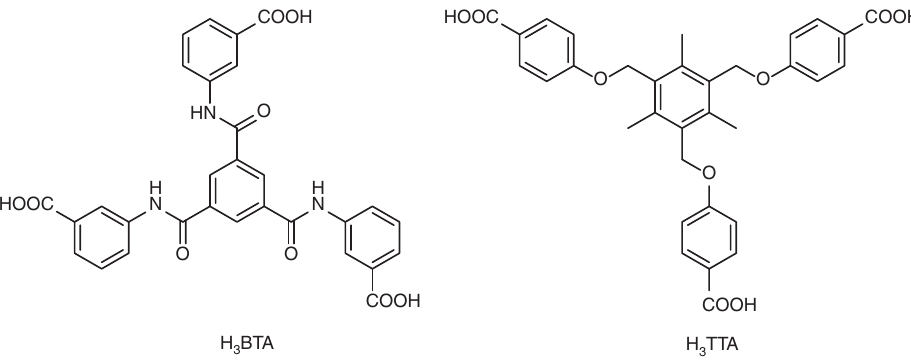
BTA and H TTA ligands employed in this 3 3